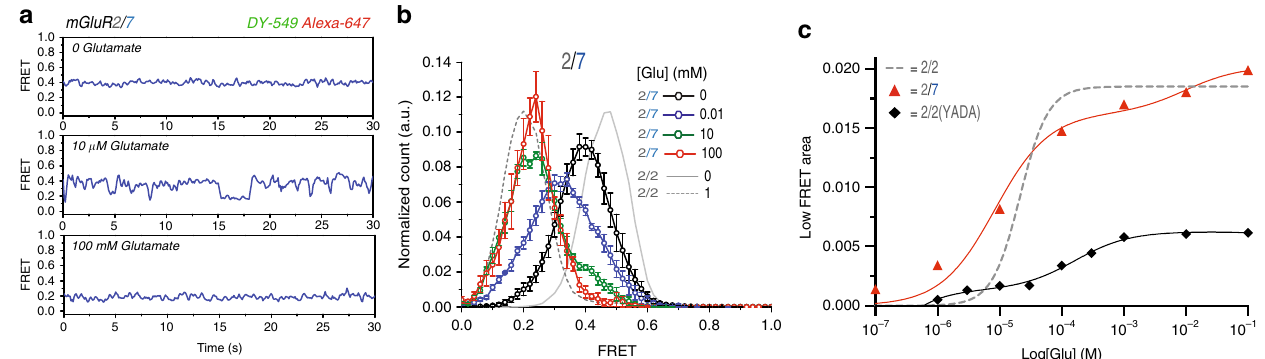
Fig. 4 The mGluR2/7 heterodimer has high glutamate af fi nity and high ef fi cacy. a Representative smFRET traces of CLIP-mGluR2/SNAP-mGluR7 labeled with BC-549 (donor) and BG-Alexa-647 (acceptor), in different glutamate concentrations, imaged at 10Hz. b smFRET histograms of CLIP-mGluR2/SNAP-mGluR7 labeled with BC-549 and BG-Alexa-647 at 0 (5 movies, 191 molecules, s.e.m. error bars), 10 μ M (7 movies, 267 molecules, s.e.m. error bars), 10mM (6 movies, 167 molecules, s.e.m. error bars), and 100mM (4 movies, 120 molecules, s.e.m. error bars) glutamate concentrations. Gray traces represent histograms of SNAP-mGluR2/SNAP-mGluR2 in 0 and 1mM glutamate (solid and broken lines, respectively). c Glutamate concentration-response relations of low FRET (activated state) peak of smFRET histograms of SNAP-mGluR2/SNAP-mGluR2 (gray dashed line single Boltzmann fi t), CLIP-mGluR2/SNAP-mGluR7 (red triangles and red solid double Boltzmann fi t) and CLIP-mGluR2/SNAP-mGluR2(YADA) (black diamonds and black solid double Boltzmann fi